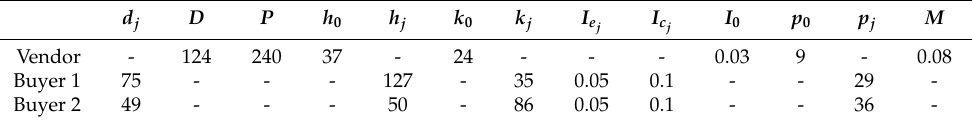
Table 4. Input data for Example